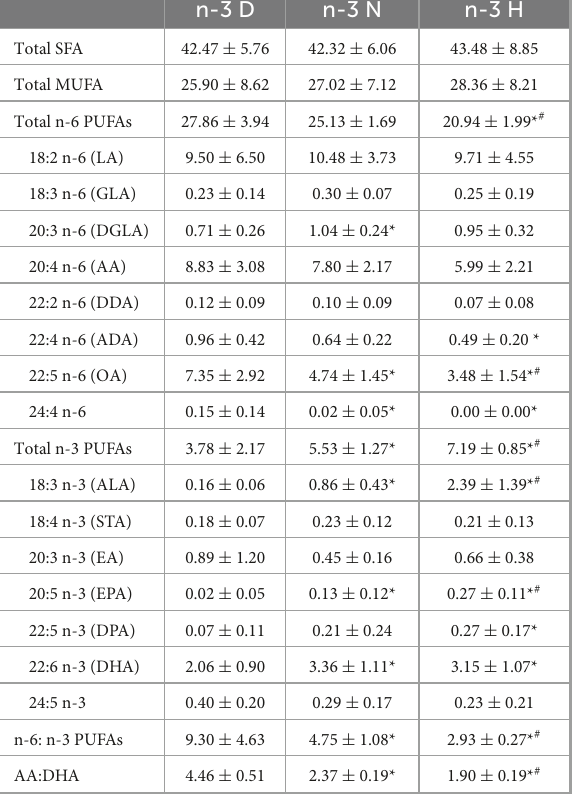
TABLE 3 Effects of paternal n-6: n-3 PUFAs on testis fatty acid concentrations in themselves (F0). n-3